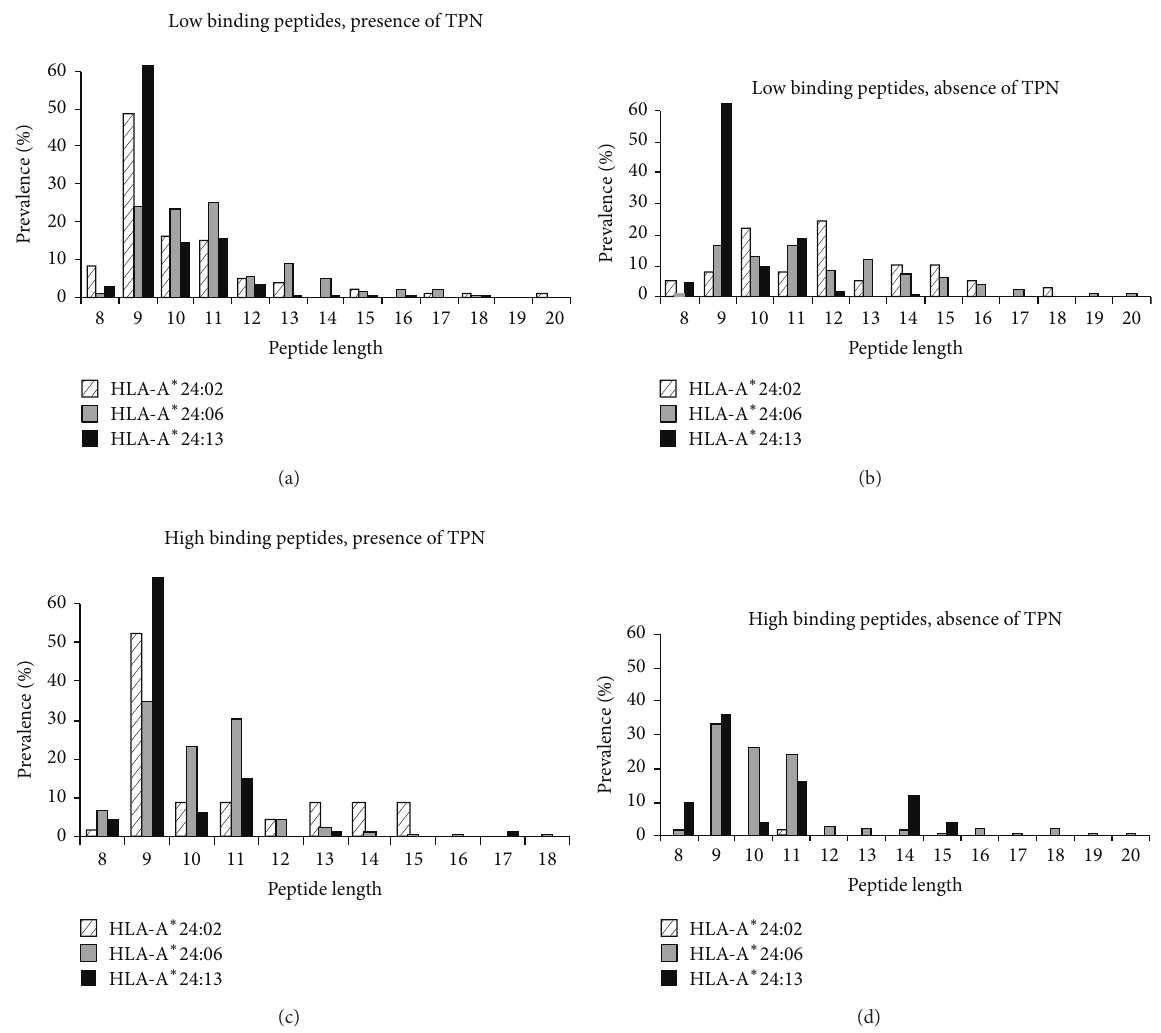
Figure 5: Length of peptides presented by HLA-A ∗ 24/156 variants. 𝑥 -axis represents the peptide length and 𝑦 -axis represents percentage prevalence of peptides of a given length. Crossed, grey, and black bars represent values from sHLA-A ∗ 24:02, sHLA-A ∗ 24:06, and HLA- A ∗ 24:13,respectively.sHLA-A ∗ 24/156variantswerefoundtopresentalargenumberofpeptidesofextraordinarylengthnotablyintheabsence of